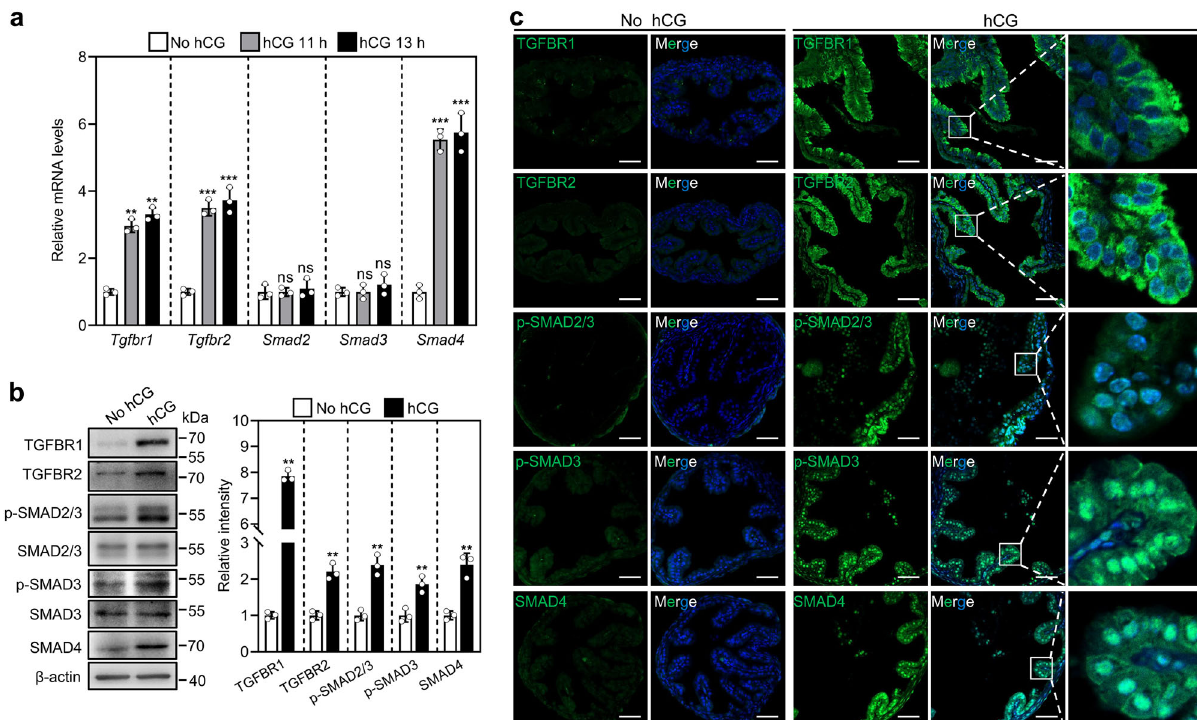
Fig. 2 LH/hCG promotes TGFBR and SMAD4 expression in the ampulla. a Comparison of steady-state levels of Tgfbr1 , Tgfbr2 , Smad2 , Smad3 , and Smad4 mRNA in the ampullae isolated from mice before and after hCG injection ( n = 3 independent experiments). b Protein levels of TGFBR1, TGFBR2, SMAD4, p-SMAD2/3, and p-SMAD3 in the ampullae isolated from mice before and after hCG injection (at 13 h post-hCG treatment). ( n = 3 independent experiments). Total levels of SMAD2/3 and SMAD3 were used as corresponding loading controls for p-SMAD2/3 and p-SMAD3, respectively, and β -actin was used as the loading control for TGFBR1, TGFBR2, and SMAD4. Bars indicate the mean ± SD. Each data point represents a biologically independent experiment. Statistical analysis was performed by one-way ANOVA Tukey test in ( a ) and by two-tailed unpaired Student ’ s t -test in ( b ). ns, no signi fi cance ( P ≥ 0.05). ** P < 0.01 and *** P < 0.001. c Immuno fl uorescence analysis of TGFBR1,TGFBR2, SMAD4, p-SMAD2/3, and p-SMAD3 (green) in the oviductal ampulla isolated from mice before and after hCG injection (at 13 h post-hCG treatment). ( n = 3 independent experiments). Nuclei were counterstained by DAPI (blue). The ampli fi ed views of the boxed area are shown on the right-hand side. Scale bars represent 50 μ